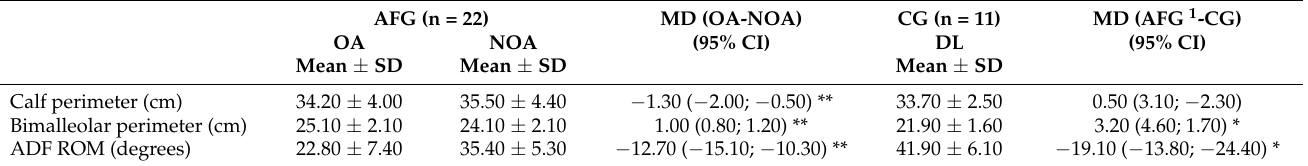
Table 2. Intra-group difference (AFG) between operated ankle/non-operated ankle and between groups (AFG-CG) of ankle perimeters (bimalleolar and calf) and ADF ROM at 6 months post-surgery. AFG (n =